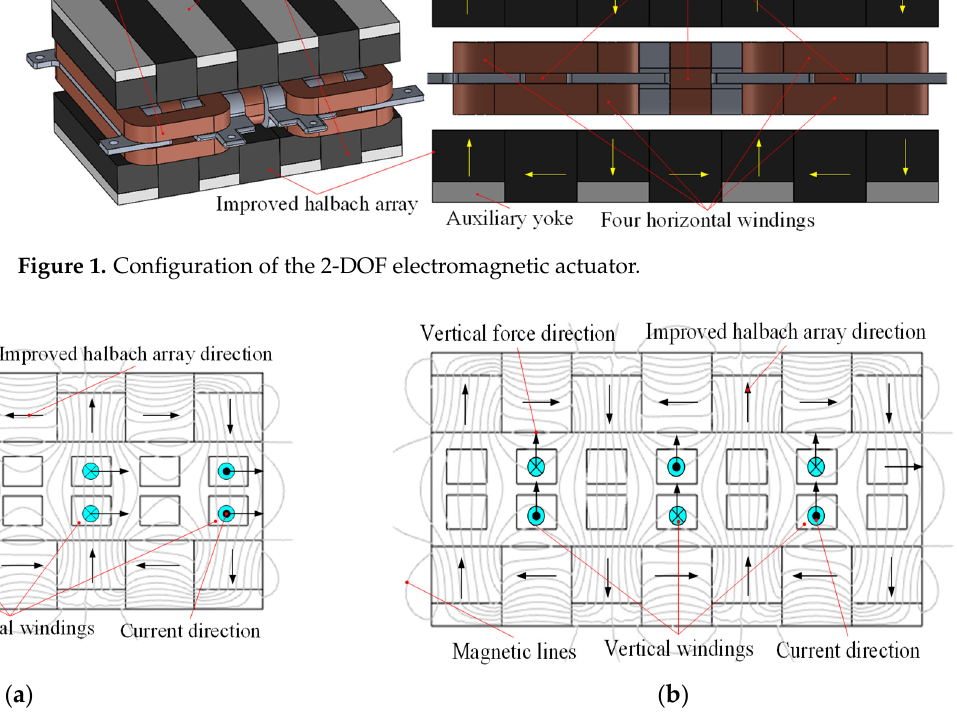
Figure 2. Working principle of the 2-DOF electromagnetic actuator: ( a ) Horizontal force; ( b ) Vertical force.